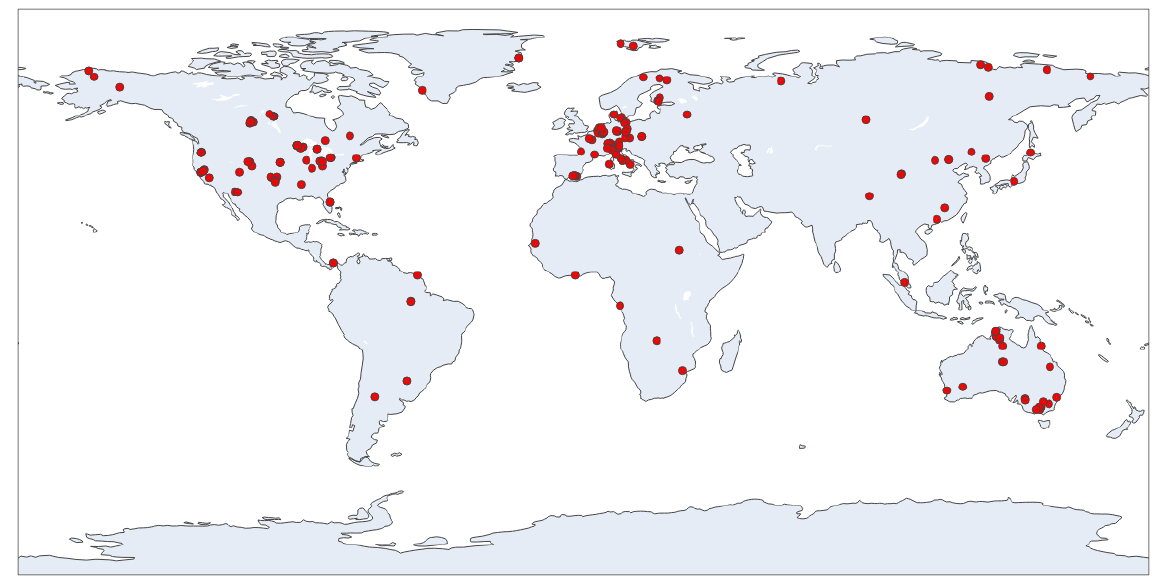
Figure 1. Locations of all Fluxnet